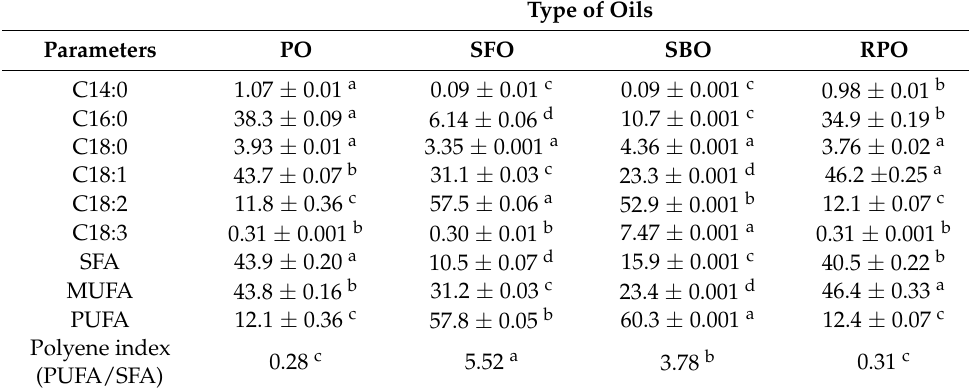
Table 4. Fatty acid composition (%) of fresh vegetable